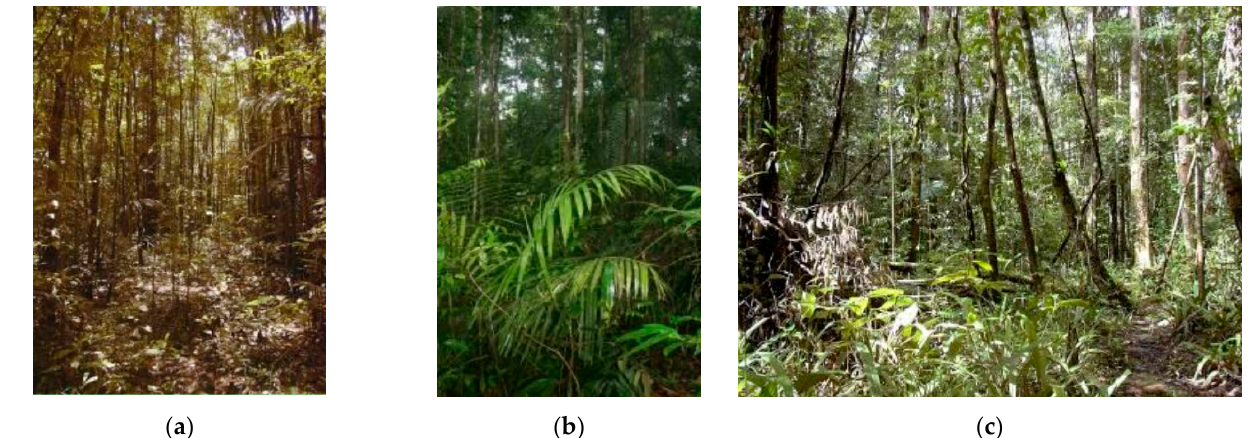
Figure 3. Sample plots with different biomass level. ( a ) Biomass level: 0~300 Mg · ha − 1 ; ( b ) biomass level: 300~400 Mg · ha − 1 ; ( c ) biomass level: 400~500 Mg · ha − 1